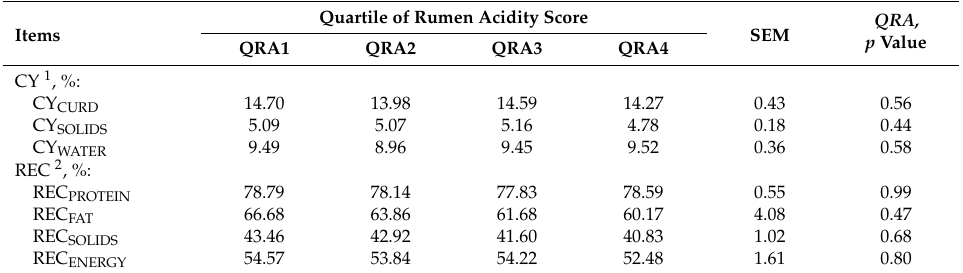
Quartile of Rumen Acidity Score